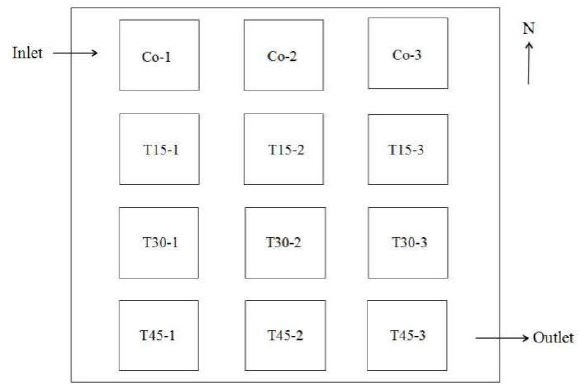
Figure 1. Experimental design field of the crab–rice field. Inlet is where the enclosure received water; the outlet is where the enclosure drained water. Co is the control group with no artificial feed supplied, and T15, T30, and T45 represent the treatment groups fed with experimental feeds of 15%, 30%, and 45% protein content, respectively. Table 1. Detailed list of contents of each experimental